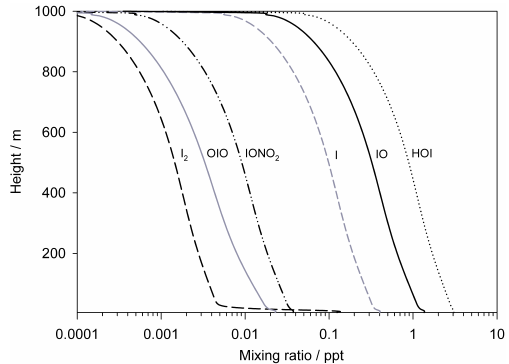
Fig. 5. Modelled vertical profiles of iodine species at Cape Verde are shown. The IO mixing ratios are seen to reduce to 10% at 500m, while OIO and I 2 would be under the detection limit of the DOAS instrument (I 2 − 15pmolmol − 1 , OIO − 10pmolmol − 1 ) all through the